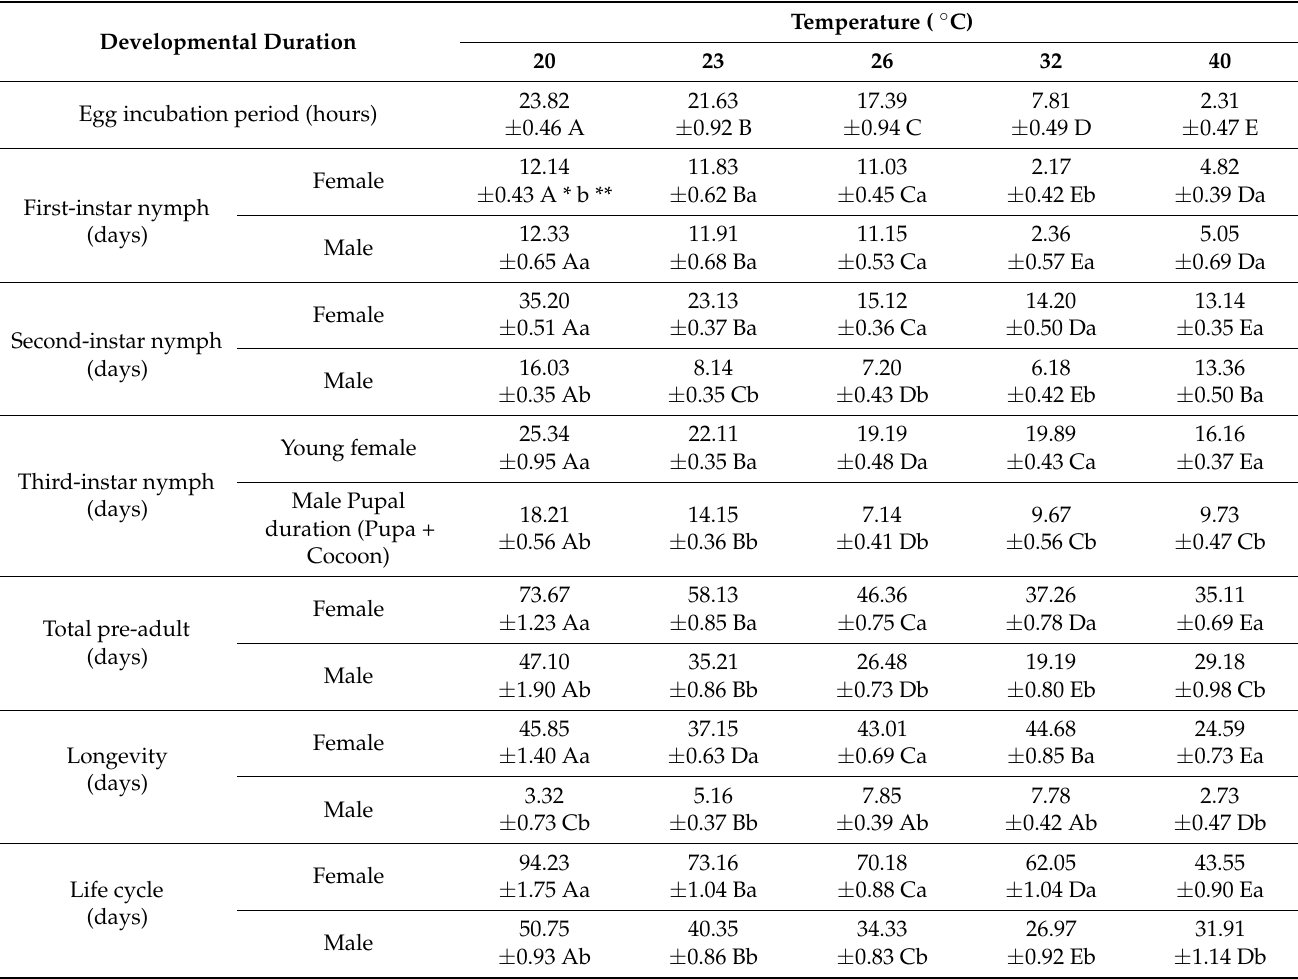
Table 1. Developmental duration (mean ± SE) of D. opuntiae female and male under different constant temperatures (20, 23, 26, 32, and 40 ◦